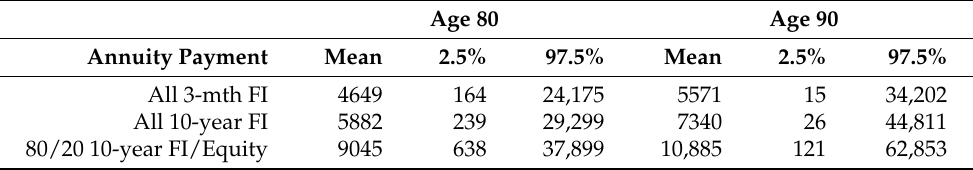
Table 8. Annuity Payment at Age 80 and 90 without volatility